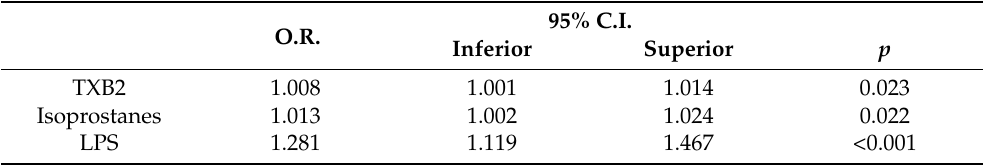
Table 2. Binary logistic regression analysis to assess the variables associated with offspring of patients with early acute myocardial infarction.